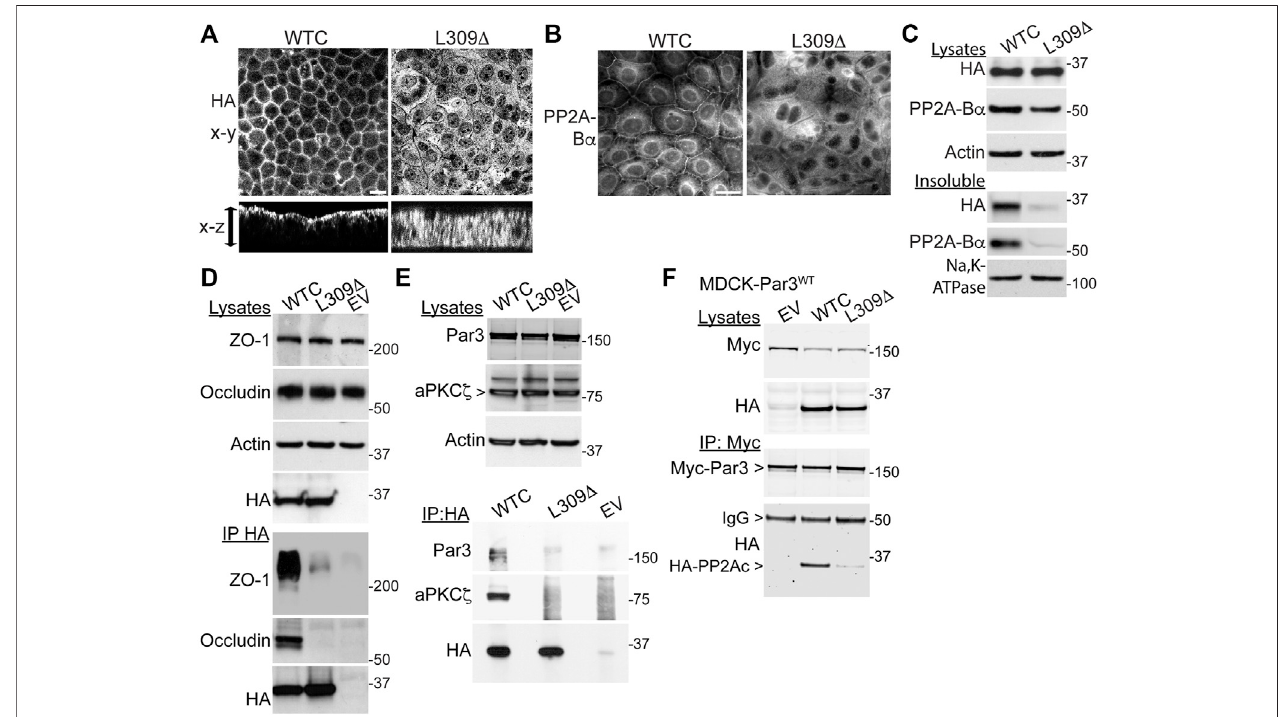
FIGURE 7 | Expression of the L309 Δ mutant in MDCK cells alters PP2A distribution and complex formation with TJ proteins and Par3. (A) Polarized MDCK monolayers were analyzed by confocal microscopy for the distribution of WTC and L309 Δ using anti-HA antibodies. Representative apical x-y and transversal x-z sections are shown; the arrow indicates the monolayer thickness. (B) Representative distribution of PP2A-B α in MDCK-WTC and MDCK-L309 Δ cells 20 h after a Ca 2+ switch. (C) Western blot analysis of HA-PP2Ac and PP2A-B α in total lysates and NP40-detergent-insoluble fractions prepared from MDCK-WTC and MDCK- L309 Δ cells cultured in NC medium. Sodium potassium pump (Na,K-ATPase), membrane marker. (D) Western blot analyses of ZO-1 and occludin in total lysates and HA-immunoprecipitates(IP)preparedfromMDCKcellstransfectedwithWTC,L309 Δ ,oremptyvector(EV). (E) WesternblotanalysesofendogenousPar3andaPKC ζ